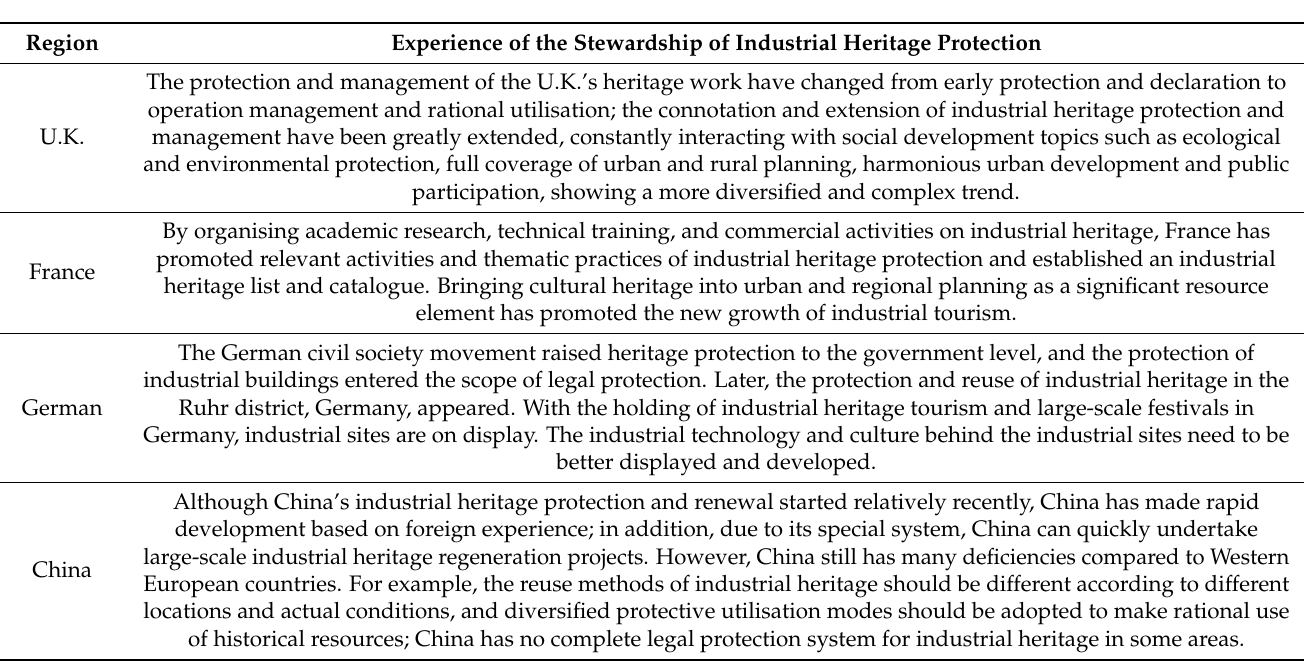
Table 4. The experience of the stewardship of industrial heritage in typical Western European and Chinese